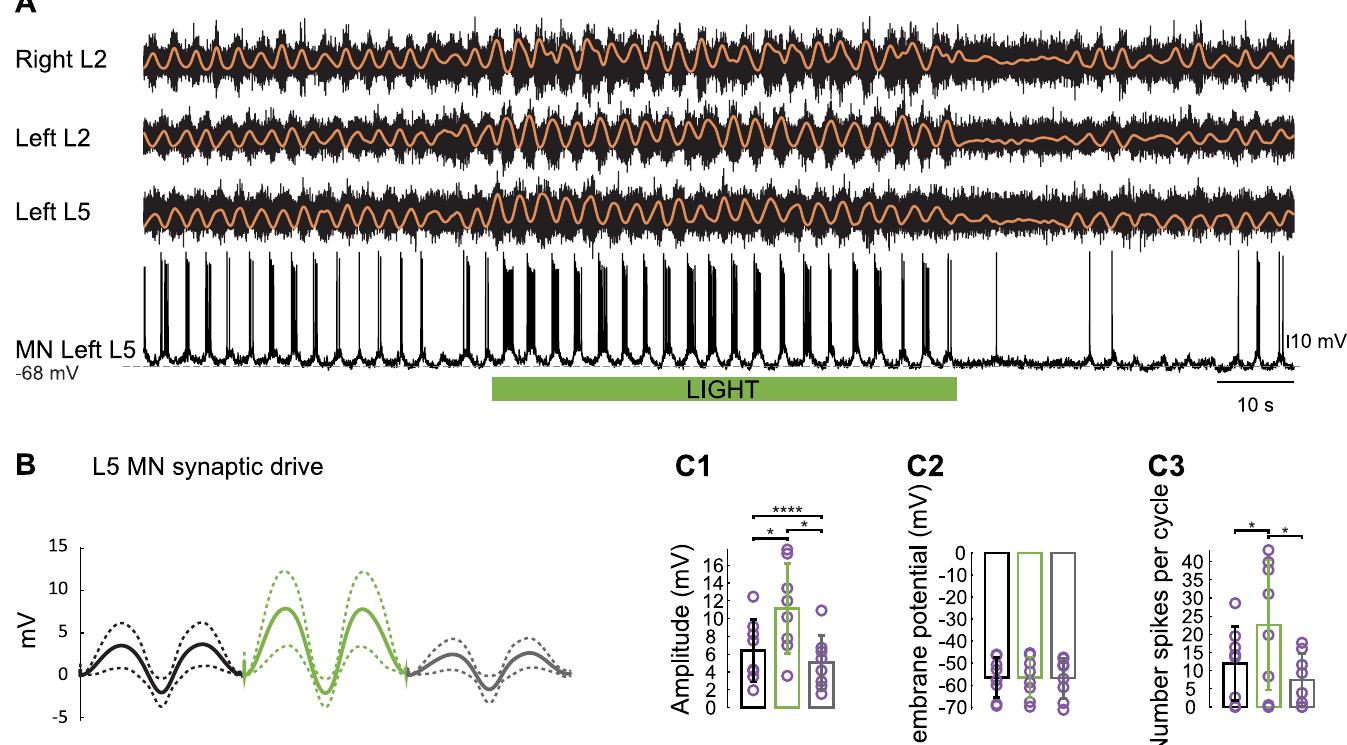
Fig 6. Light-induced hyperpolarization of V1 interneurons increases the rhythmic synaptic drive to MNs during drug-induced locomotor-like activity. (A) Locomotor-like activity evoked by 5 μ M NMDA, 10 μ M 5-HT, and 50 μ M DA in an En1 -Arch spinal cord. The black traces show the high-pass (10 Hz) filtered signal from the right and left L2 and the left L5 ventral roots together with a flexor MN recorded from the left L5 segment. The superimposed orange traces are the integrated neurograms. (B) Cycle-triggered average (continuous line) and standard deviation (dotted lines) of the synaptic drive to an MN during fictive locomotion (two cycles) in an En1 -Arch spinal cord ( n = 8) before (black), during (green), and after (gray) illumination. (C) Bar plot of the amplitude of the synaptic drive ([C1]; Friedman test, p < 0.0001), the membrane potential ([C2]; Friedman test, p > 0.9999), and the number of spikes per cycle ([C3]; Friedman test, p = 0.0072) in MNs recorded in an En1 - Arch spinal cord during fictive locomotion before (black), during (green), and after (gray) illumination. � p < 0.05, ���� p < 0.0001. The data underlying this figure can be found in S5 Data. 5-HT, 5-hydroxytryptamine; Arch, archaerhodopsin-3; DA, dopamine; En1 , engrailed-1 ; MN, motoneuron; NMDA,